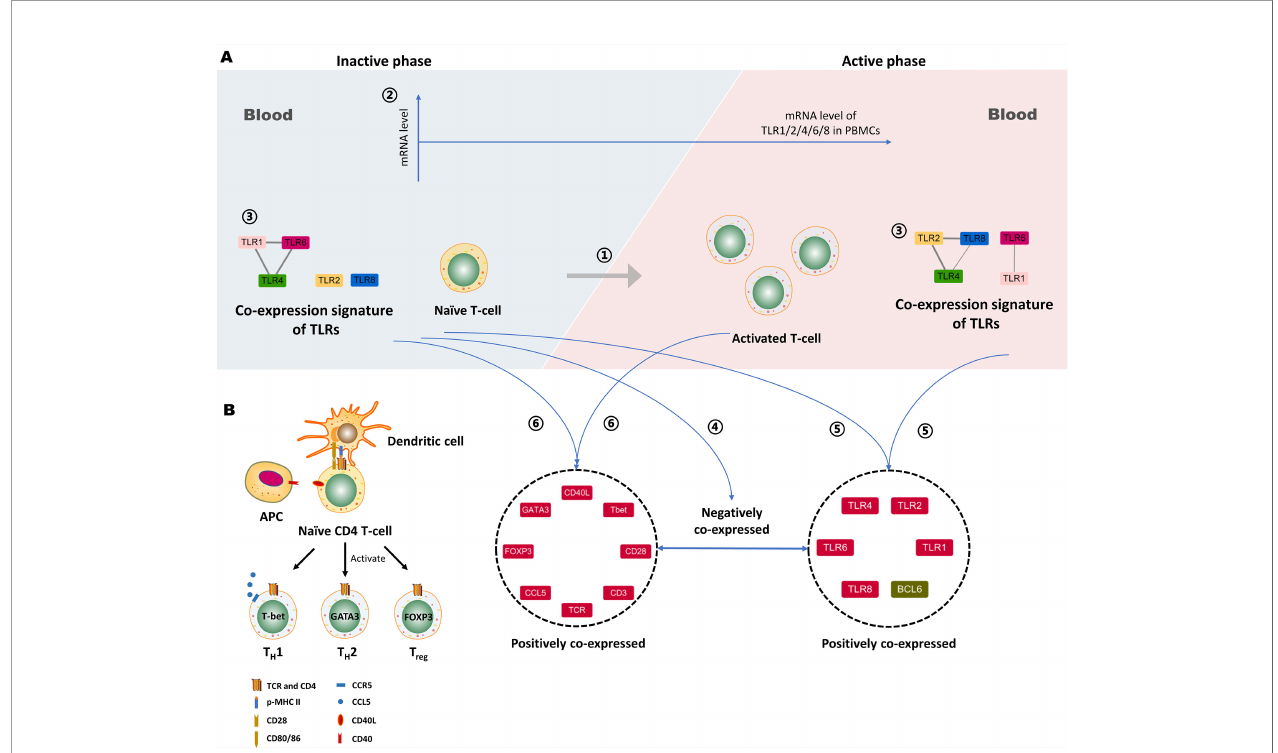
FIGURE 13 | Proposed working model depicting the association between Toll-like receptors (TLRs) and T-cell activation in Takayasu ’ s arteritis (TAK). (A) ① The activation of autoreactive T cells contributes to the disease activity of TAK. ② The mRNA level of TLR1, -2, -4, -6 or, -8 in peripheral blood mononuclear cells (PBMCs) do not statistically change with alterations when patients with TAK enter the active phase, which was concluded from the comparison between the active patients and the inactive ones. ③ The gene co-expression of TLRs might serve as a biomarker that could distinguish active patients from inactive patients in TAK. ④ The negative gene co-expression between the TLRs cluster and the gene cluster associated with T-cell activation and differentiation is a characteristic of inactive- treated TAK patients that is absent in the active ones. ⑤ The inactive TAK patients and the active TAK patients share the characteristic of the positive co-expressed gene cluster comprising several key genes involved in the activation and differentiation of T-cells. ⑥ The inactive TAK patients and the active TAK patients have the common positive co-expressed gene cluster comprising TLRs and BCL6. Notably, BCL6 is tightly related to TLRs, and the underlying mechanisms deserve further exploration. Besides, miRNAs might play an important role in the above gene co-expression, and however, further investigation is needed to validate it. (B) The proteins coded by the genes in the left gene cluster play a key role in the activation and differentiation of T-cells. APC, Antigen-presenting